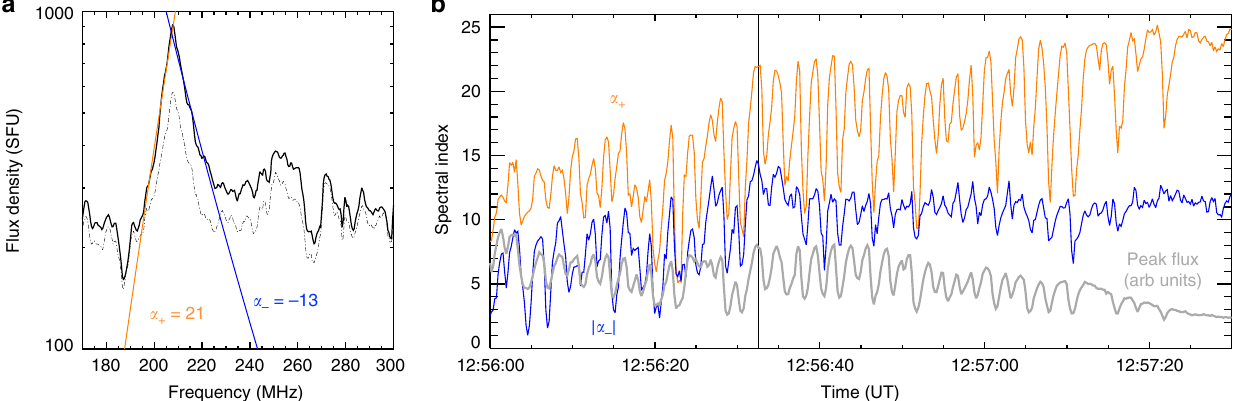
Fig. 6 Pulsation fl ux density spectrum properties throughout time. a Flux density spectrum of a single pulse taken from the Orfées dynamic spectrum, showing pulse maximum at 12:56:30 UT in solid and pulse trough (approximately 1 s later) in dot-dash. Fits to both the positive (orange) and negative (blue) slopes of the pulse at max intensity indicate spectral indices of α + = 21 and α − = − 13. b The spectral indices over time for a subset of the pulsations from 12:56:00 to 12:57:30 UT, showing that the pulsing in intensity is also accompanied by a pulsing in the spectral indices